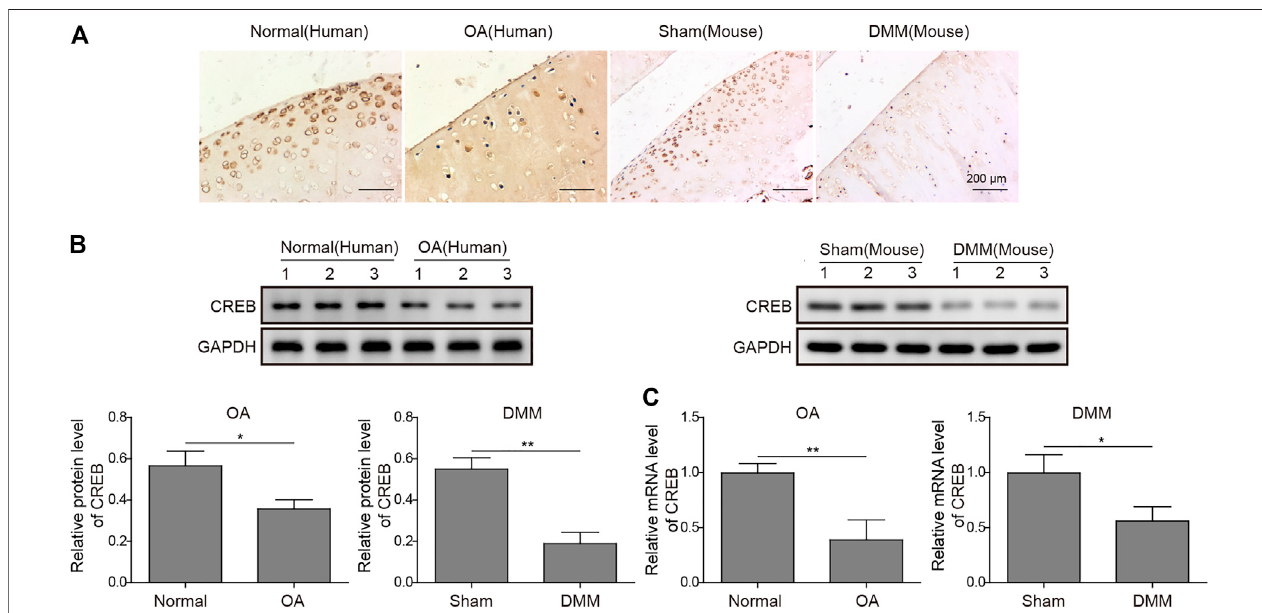
FIGURE 1 | Abnormal expression of CREB in clinic human OA tissues and surgically induced mouse OA model. (A) The in situ expression changes in human OA samples and mouse-induced OA tissues were examined by IHC. Scale bar = 200 μ m. (B) The protein level of CREB was determined by Western blotting and then quanti fi ed. CREB signal was normalized to GAPDH intensity. (C) The expression of CREB mRNA was determined by qRT-PCR. GAPDH was used as the endogenous reference for normalization. p < 0.05 was marked as *, p < 0.01 was marked as **.